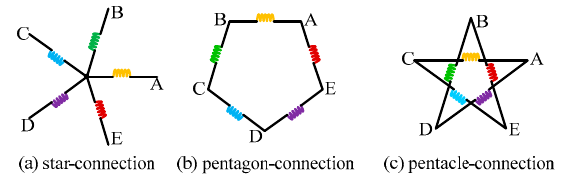
Figure 1. Stator winding connection modes.